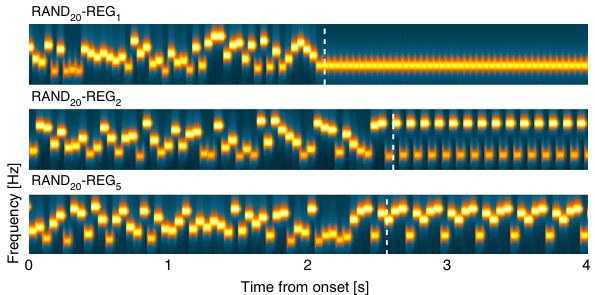
Fig. 9 Example spectrograms for the additional stimuli used in Exp 4A, B. RAND 20 -REG 1 consisted of a transition from a random sequence (generated by sampling frequencies from the full pool with replacement; RAND 20 ) to a single repeating tone. RAND 20 -REG 2 consisted of a transition from a RAND 20 sequence to a regular pattern consisting of two randomly selected tones. RAND 20 -REG 5 , consisted of a transition from a RAND 20 sequence to a regular repeating pattern consisting of 5 tones. Dashed vertical white lines indicate the transition time, de fi ned as occurring after the fi rst full regularity cycle. See also Supplementary Fig. 2 for an information theoretic 28 characterization of the stimuli: All transition conditions show a gradual decline in information content (IC) over several tones as the model discovers the predictable structure within the sequence. For presentation purposes the plotted sequence lengths are equal. Actual durations varied randomly between 6 and 7.5 s. In Experiment 4A the stimulus set also contained RAND 20- REG 10 , REG 10 -RAND 20 , STEP, REG 10 , RAND 20 and CONST sequences. In Experiment 4B the stimulus set additionally contained RAND 20 -REG 10 and RAND 20